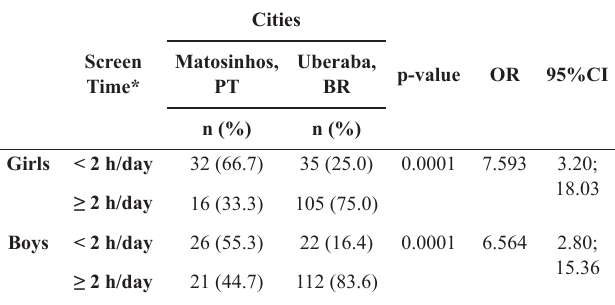
Table 2. Association between screen time recommendation and cities, by gender, in children from Matosinhos, Portugal and Uberaba, Brazil